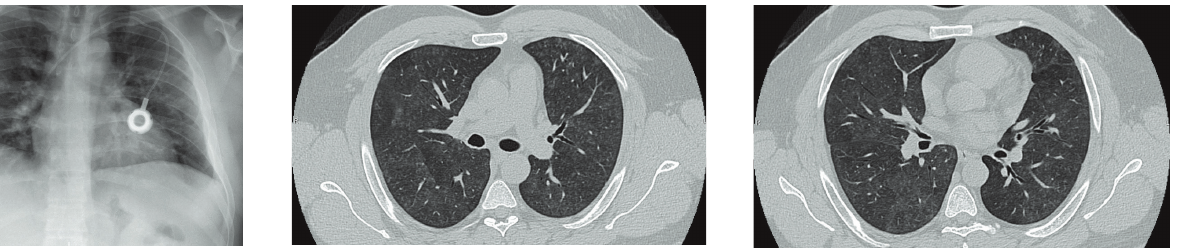
Fig. 1. Plain PA chest radiograph. Fig. 2. Axial HRCT at pulmonary artery level. Fig. 3. Axial HRCT at aortic root level.